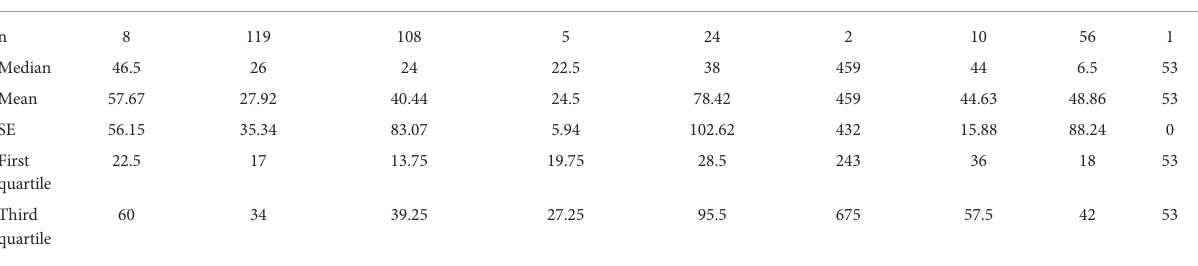
TABLE 5 Onset time (days).